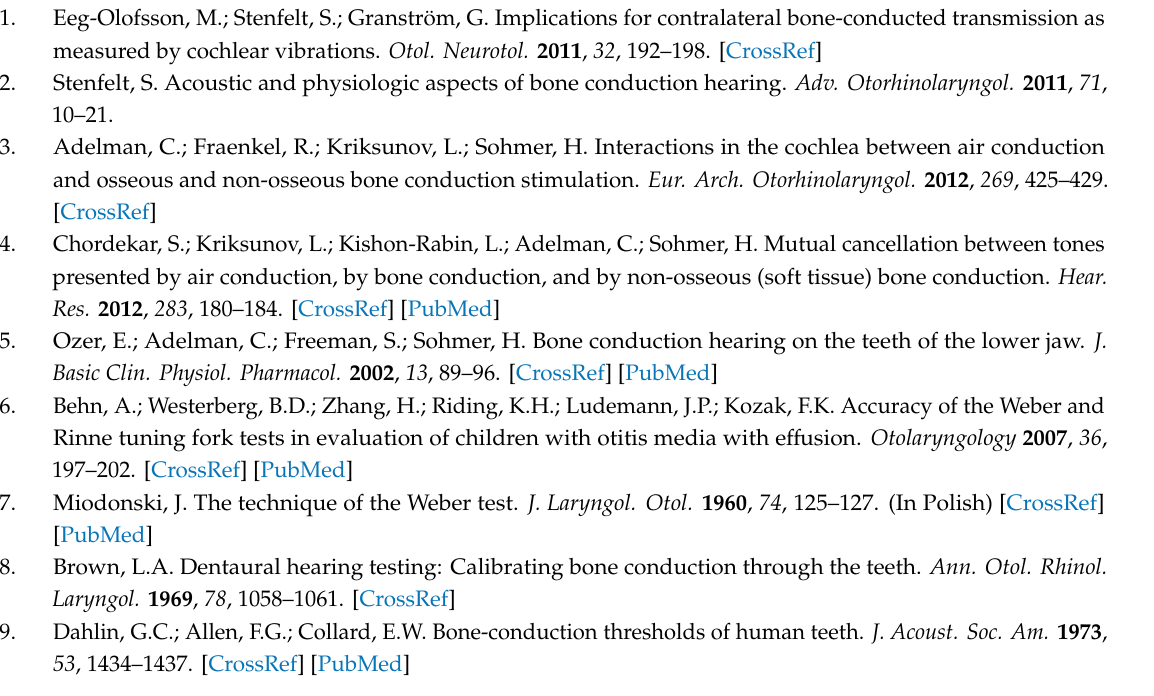
Figure S1: Frequency characteristics of transmittance (vibration velocity in the cochlear area in comparison to exciting the inductor on the mastoid) in di ff erent states of dentition for left side, Figure S2: The e ff ective vibration velocity vRMS (mm / s) measured on the left side of skull No1 in the 500 Hz bands. Four states of dentition (column chart), Figure S3: Graphical presentation of the result of the multiple comparison test during mastoid stimulation. Skull No. I on the left side in the analyzed dental conditions in selected frequency bands, Table S1: Basic statistics (mean ± SD, median (cid:104) Q 1 ; Q 3 (cid:105) ) of the velocity amplitude from the mastoid process of the skull No. I on the left side in the analyzed dental conditions in selected frequency bands and the result of the multiple comparison